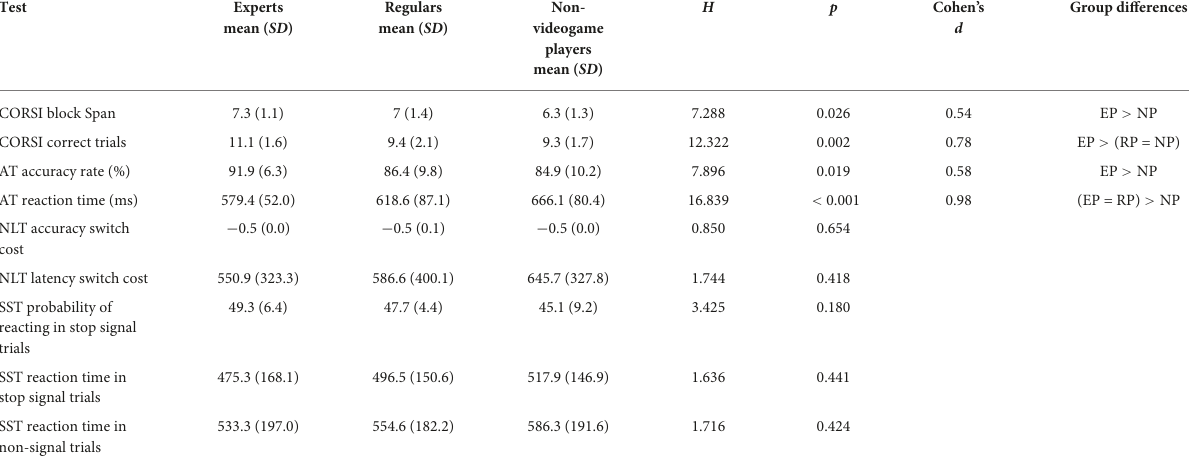
TABLE 3 Cognitive performance differences among Experts Players (EP), Regular Players (RP), and Non-videogame Players